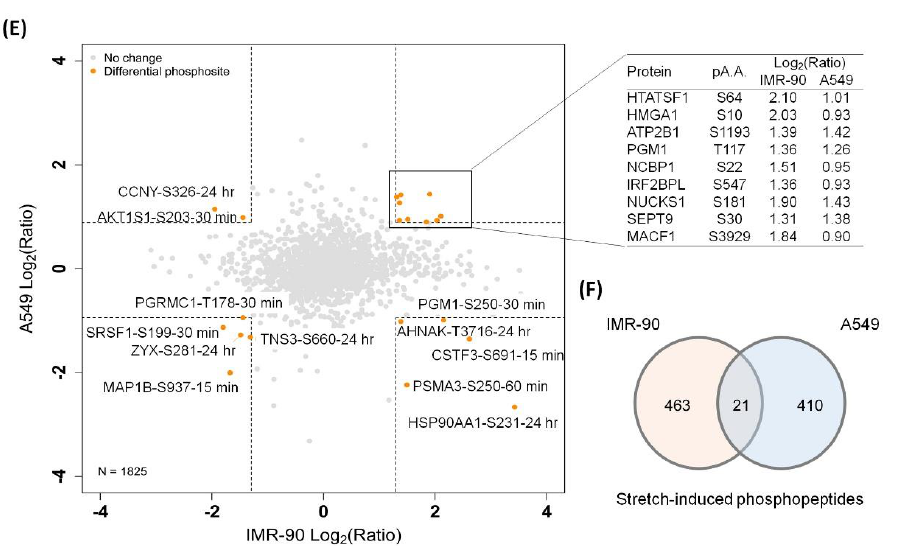
Figure 2. Quantitative phosphoproteome profiling of stretched A549 and IMR-90 cells. ( A , B ) The quantitation and identification of the phosphoproteome of IMR-90 and A549 lung cells in response to cyclic stretching. In IMR-90, 1345 phosphopeptides, corresponding to 837 phosphoproteins were identified in. One phospho-group identified on one peptide is represented by 1p, 2p represents two phospho-groups identified on one peptide, etc. Phosphorylated residues of serine, threonine, and tyrosine are indicated as pS, pT, and pY. Localization probability represents the reliability of the phosphorylated position, while phosphosites having a probability of more than 0.75 represent a higher confidence. ( C , D ) Histogram of log 2 -transformed normalized phosphosites in IMR-90 ( C ) and A549 ( D ) cells. Red lines indicate the threshold of di ff erential phosphosites (mean ± 1.5 SD). Symbol (cid:78) and the number below it show the up-regulated phosphosites induced by cyclic stretching. Symbol (cid:72) and the number below it show the down-regulated phosphosites induced by cyclic stretching. ( E ) Scatter plot illustrating the overlapping phosphosites identified in the two cell lines. ( F ) Venn diagram of significantly regulated phosphopeptides that are conserved in cyclic